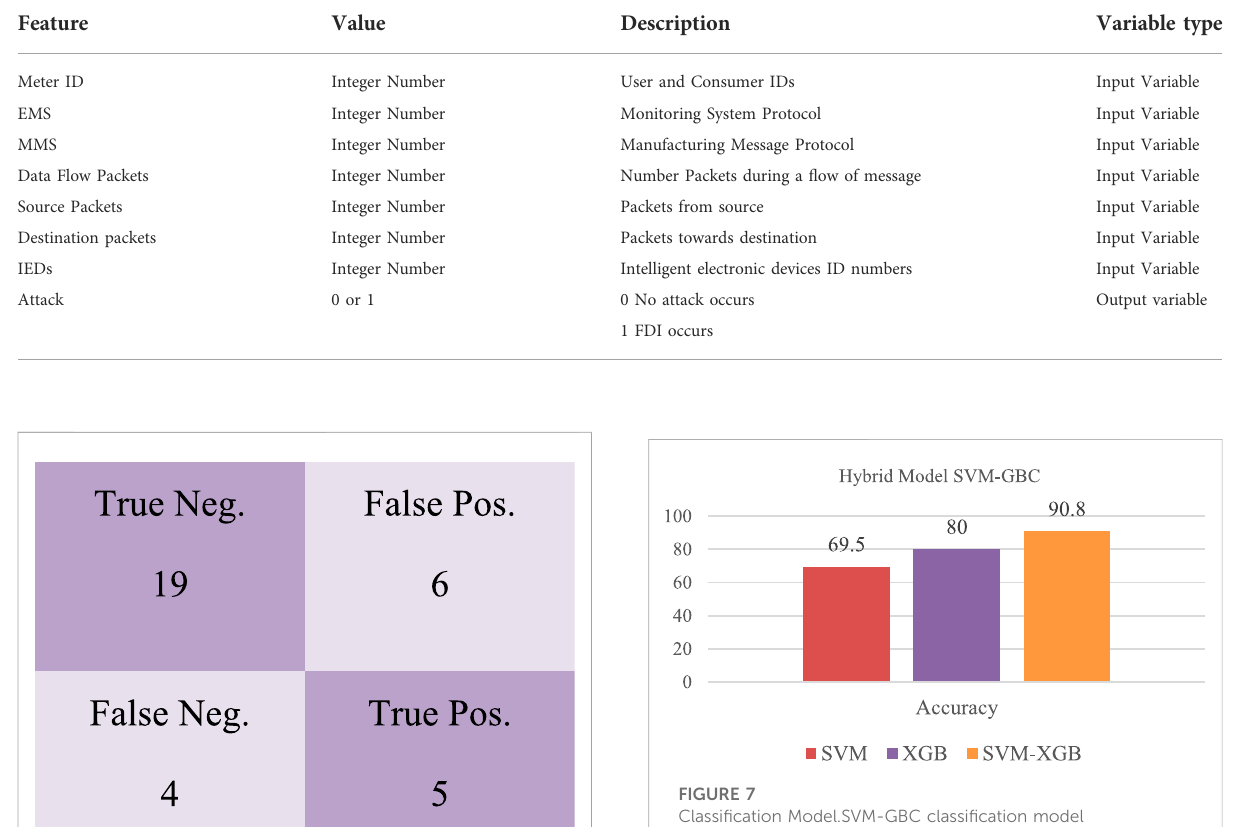
FIGURE 7 Classi fi cation Model.SVM-GBC classi fi cation model